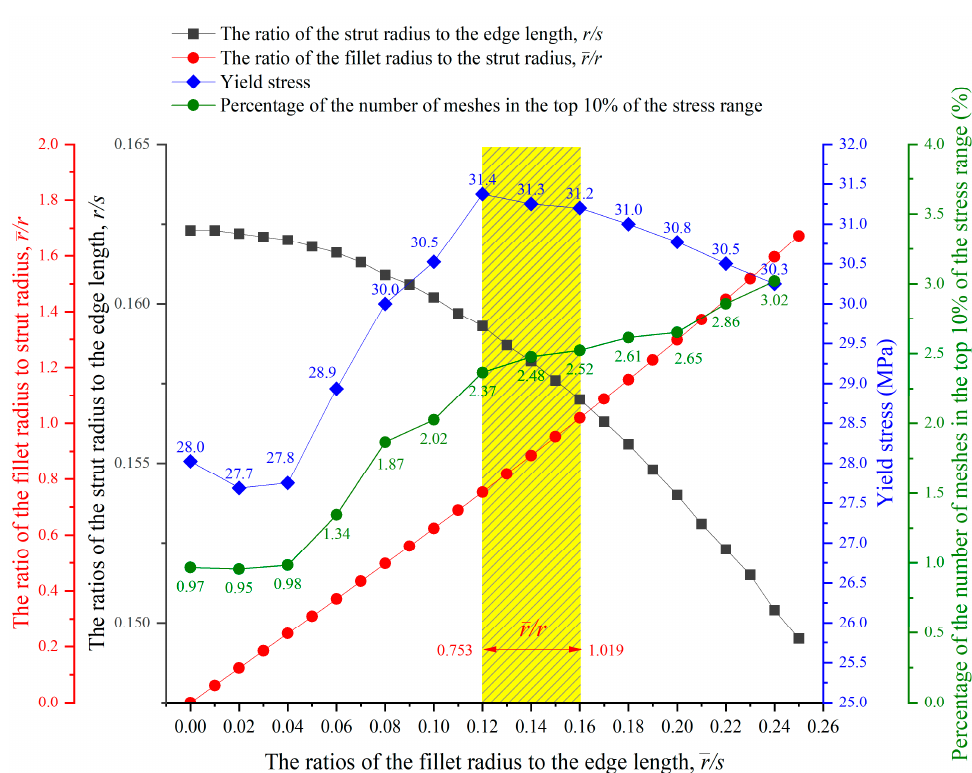
Figure 15. FEA results for the fi llet edgeless simple cubic unit cells.